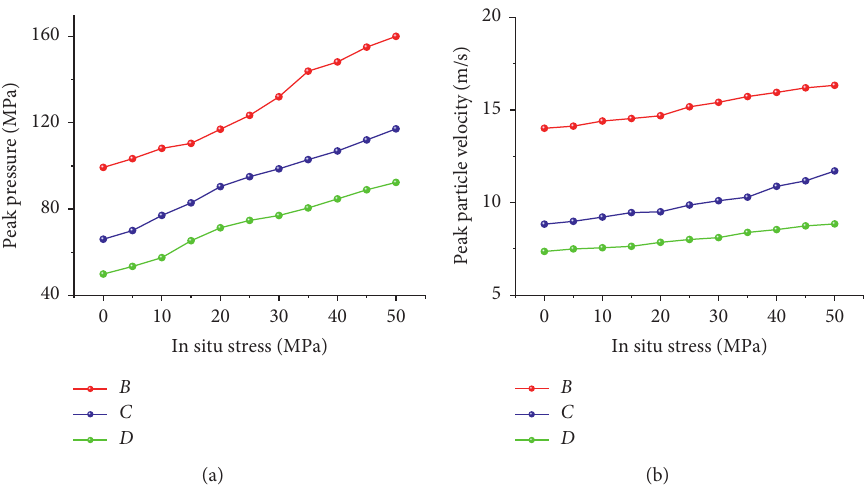
Figure 12: (a) Peak pressures and (b) peak particle velocities (PPVs) under different in situ stresses at points B , C , and D